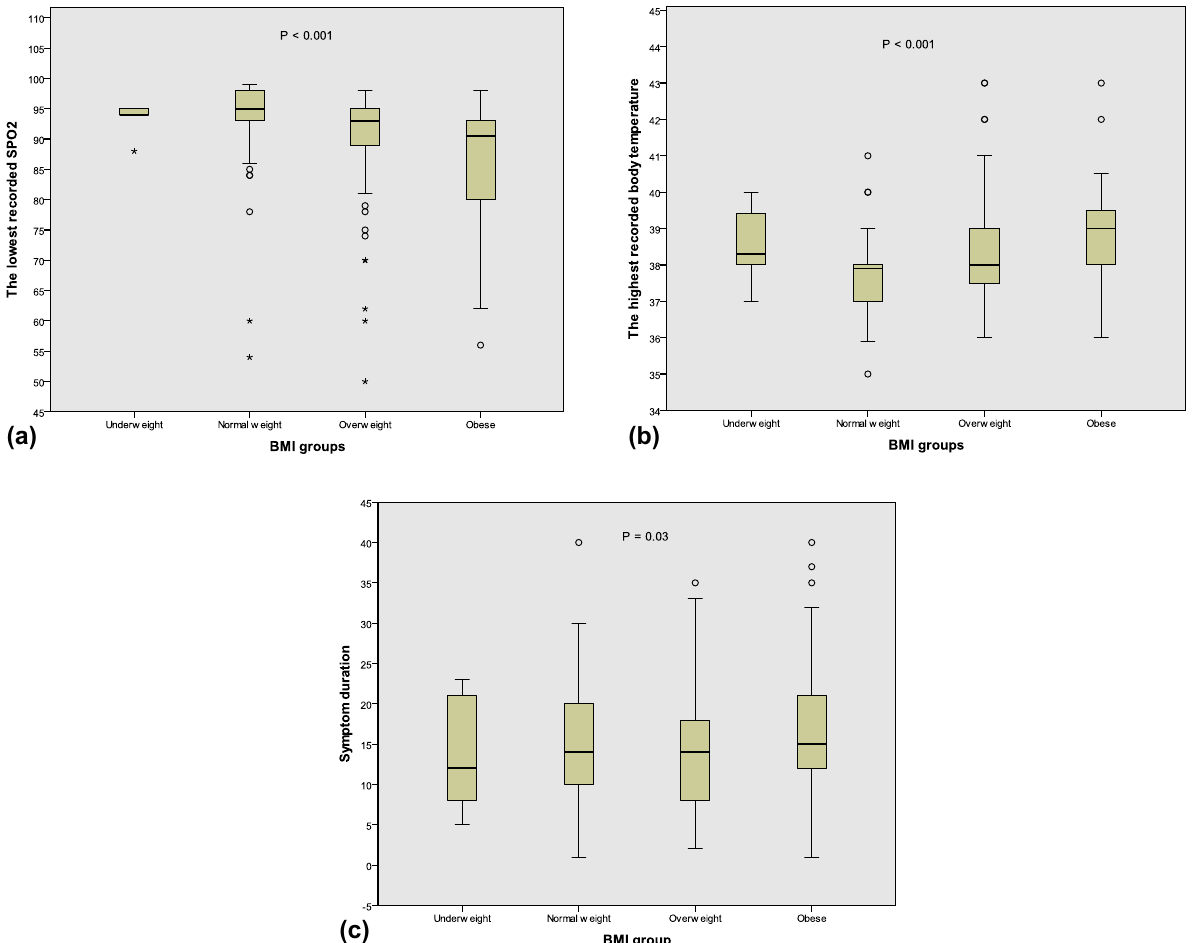
Figure 3: Comparison of the lowest recorded SpO 2 ( a ) , highest recorded body temperature ( b ) , and symptom duration ( c ) between the di ff erent BMI